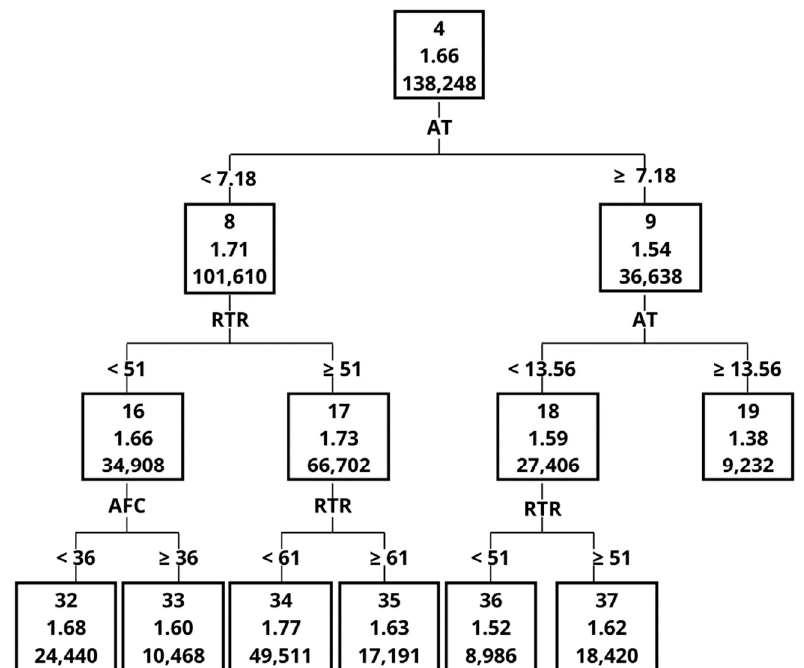
Figure 3. The graphical model of the decision tree—part 2.